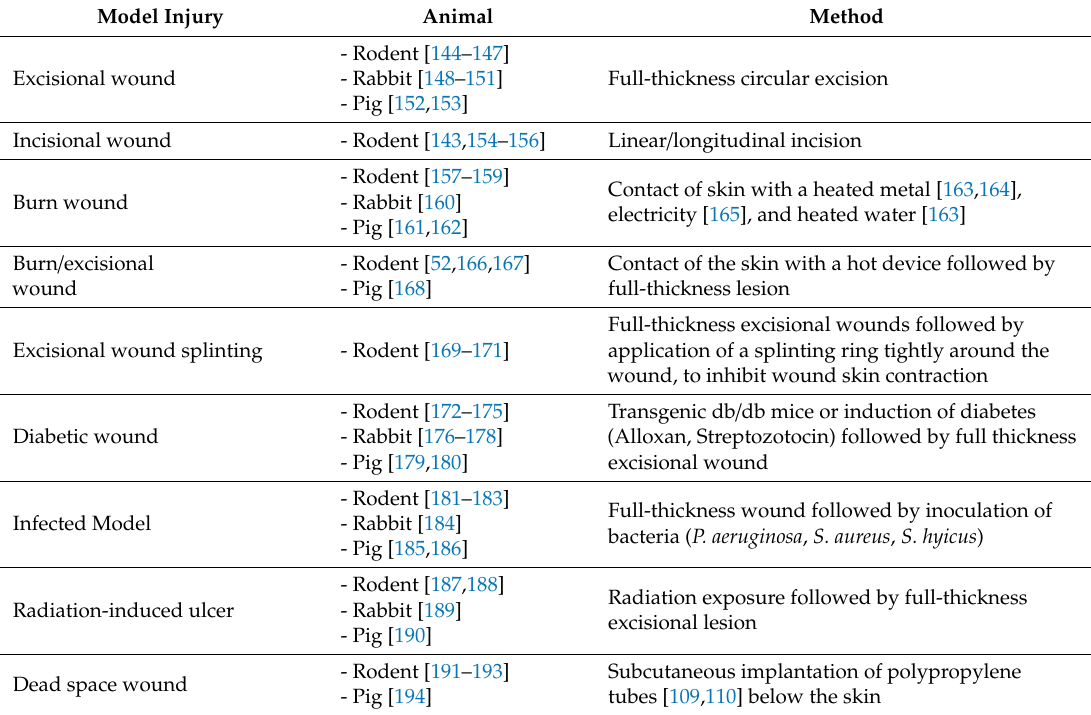
Table 5. Di ff erent types of wound models to study the wound healing